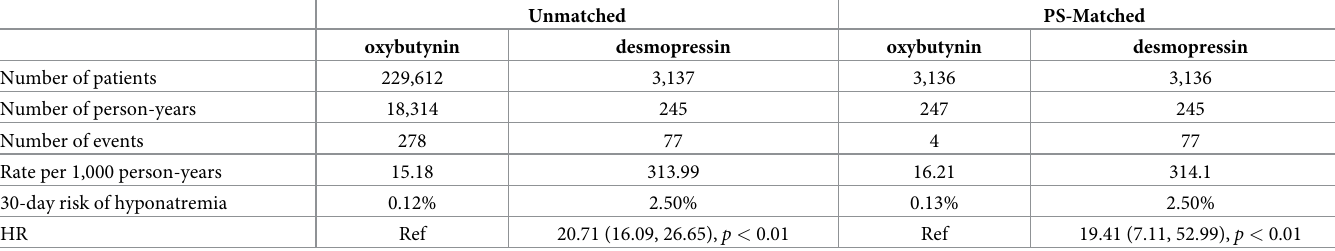
Table 3. Rate of hyponatremia within 30